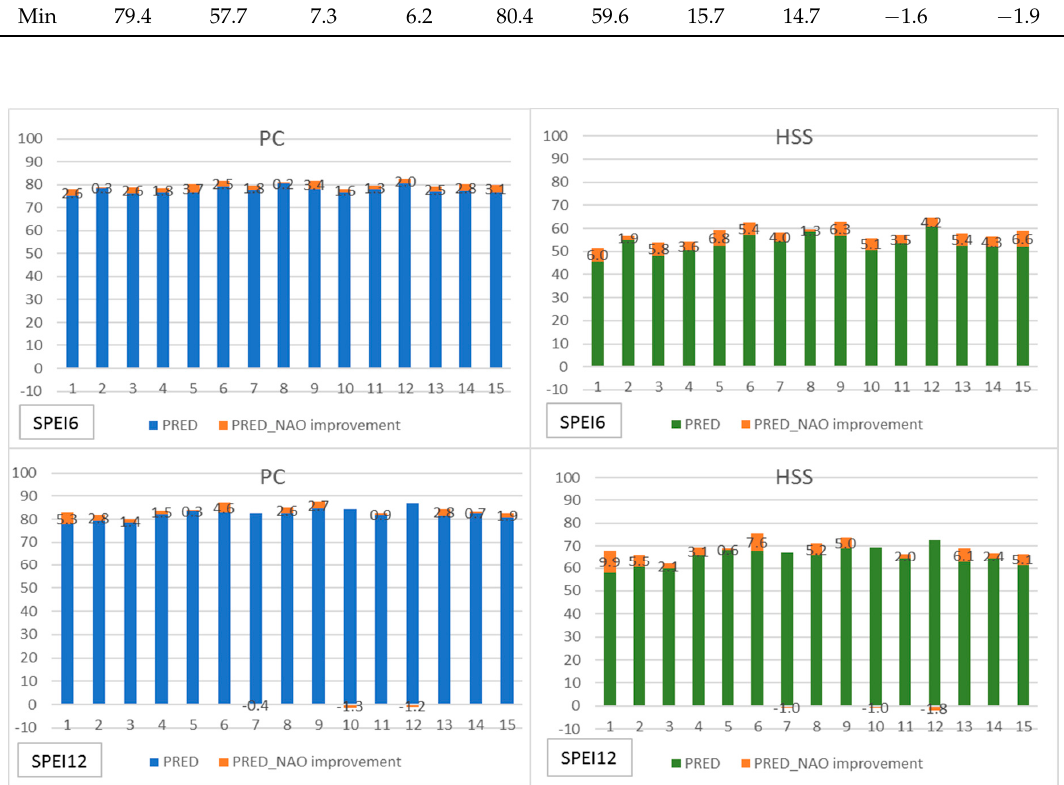
Figure 5. PC and HSS improvement (%) considering the influence of NAO on the SPEI6 and SPEI12 modeling for the extended winter months for each of the 15 grid points.